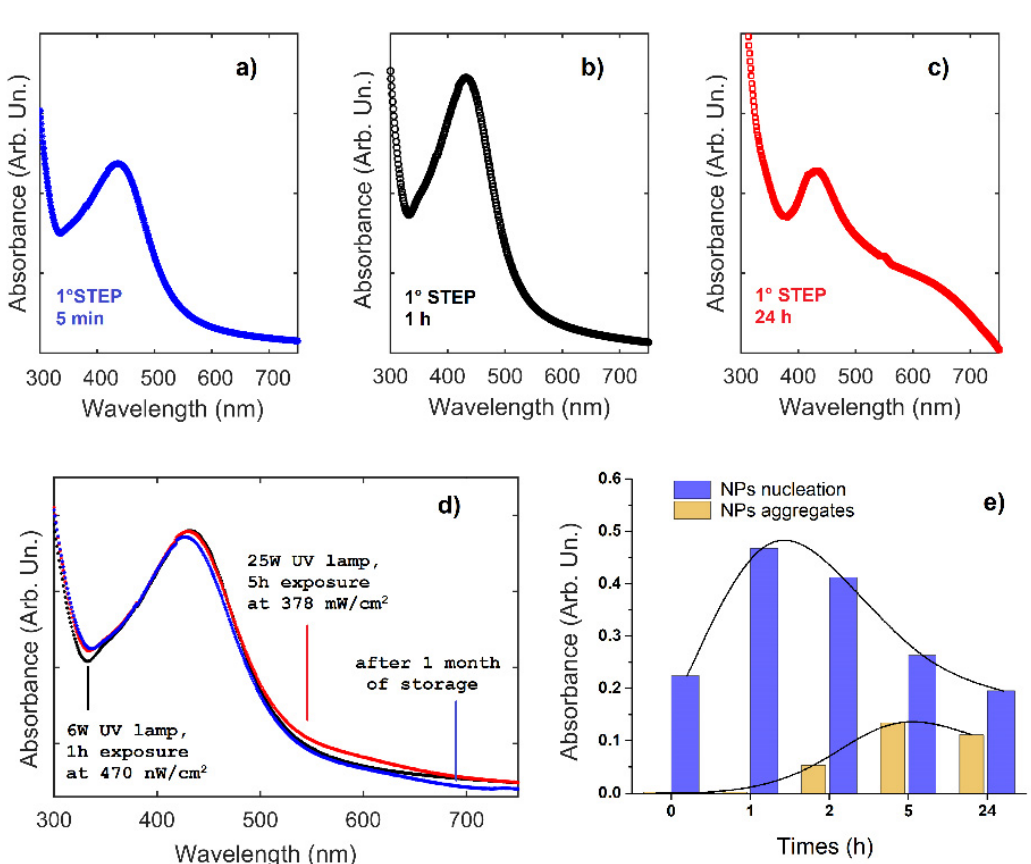
Figure 2. UV-vis optical absorbance spectra at different times during the first ( a – c ) and second ( d ) step of UV irradiation treatment to prepare Ag-PMA nanocolloid. The spectrum after one month by the second step of irradiation is also shown ( d ). The optical absorbance value vs. time is reported in panel ( e ) for the two main processes (NPs nucleation and aggregates).